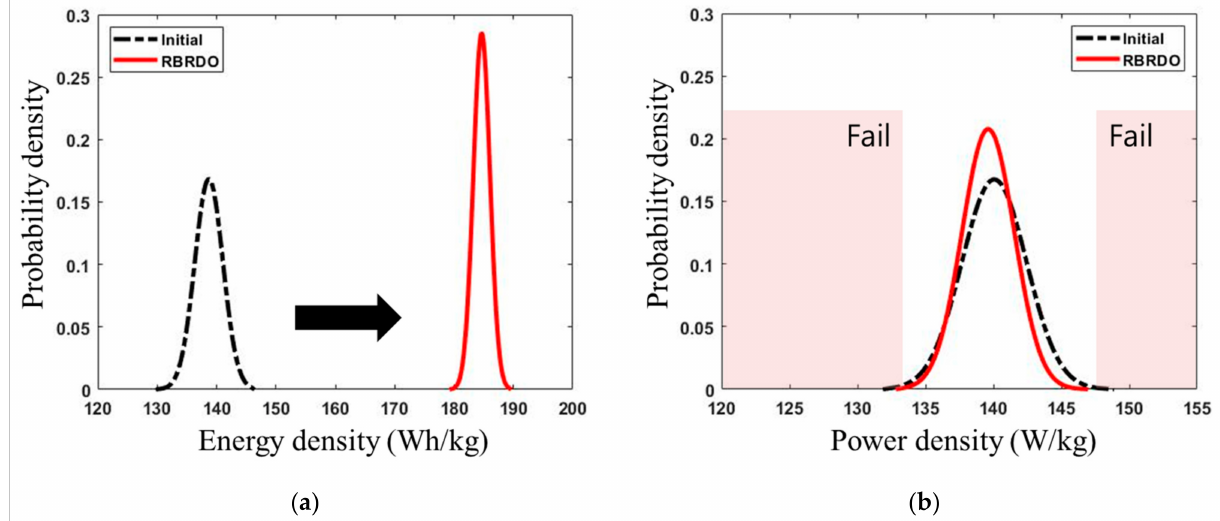
Figure 6. Comparison of initial and RBRDO results for ( a ) energy density and ( b ) power